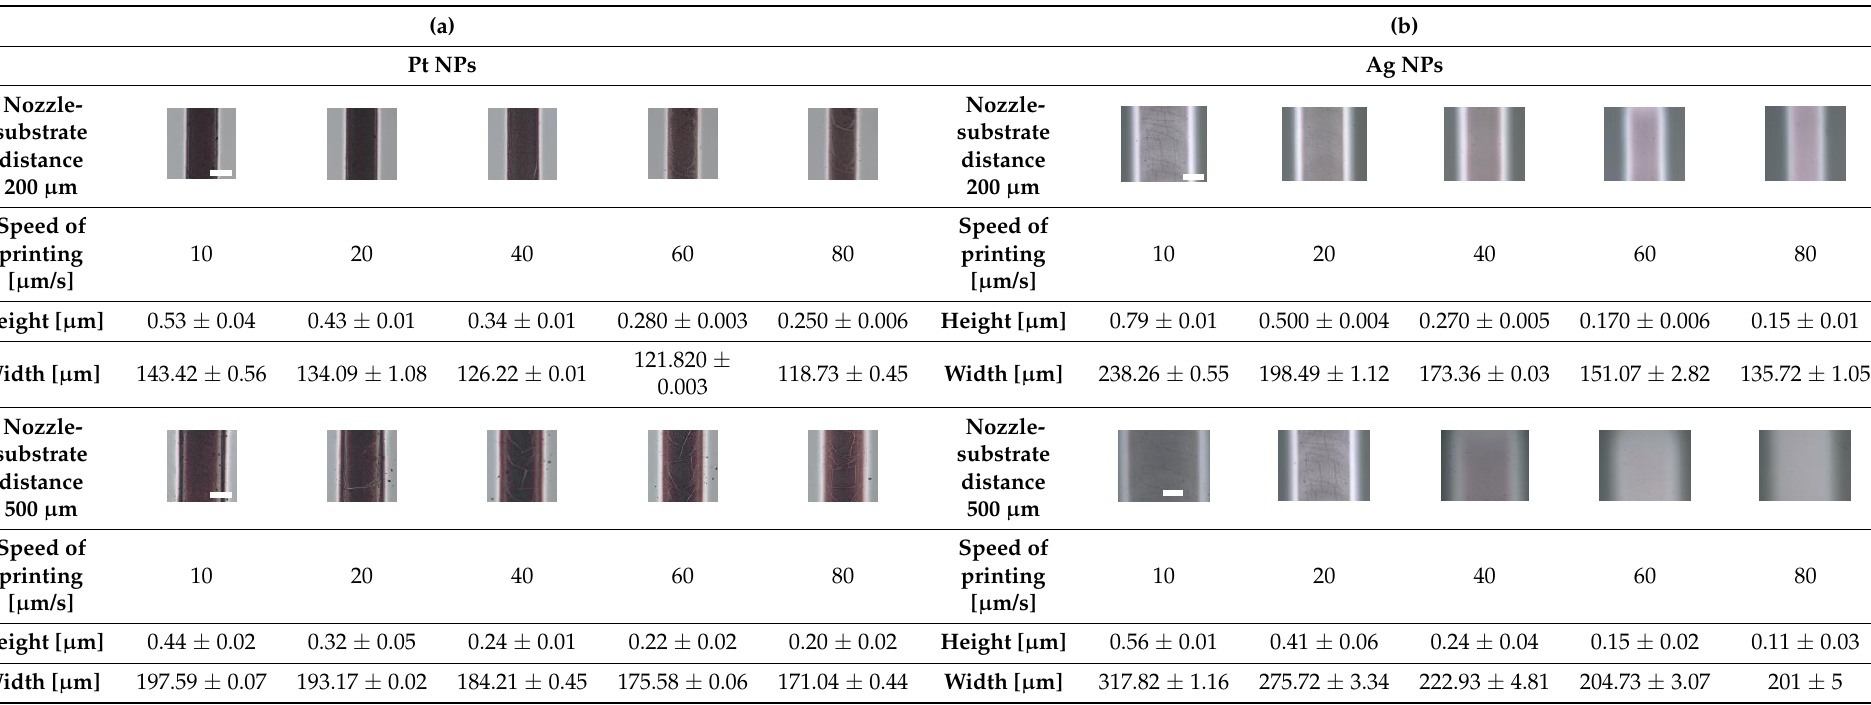
For each speed of printing, 3 lines of 1 mm were printed on PDMS substrates and the standard deviation of width and thickness was evaluated on 3 different points along each line. Slower deposition speeds result in thicker lines, as a higher amount of NPs is focused on the substrate per unit of time. All lines were printed using a nozzle throat of 100 µ m, and the voltage and the current setting for the spark discharge were 1.3 kV and 10 mA respectively. Scale bars 100 µ m.